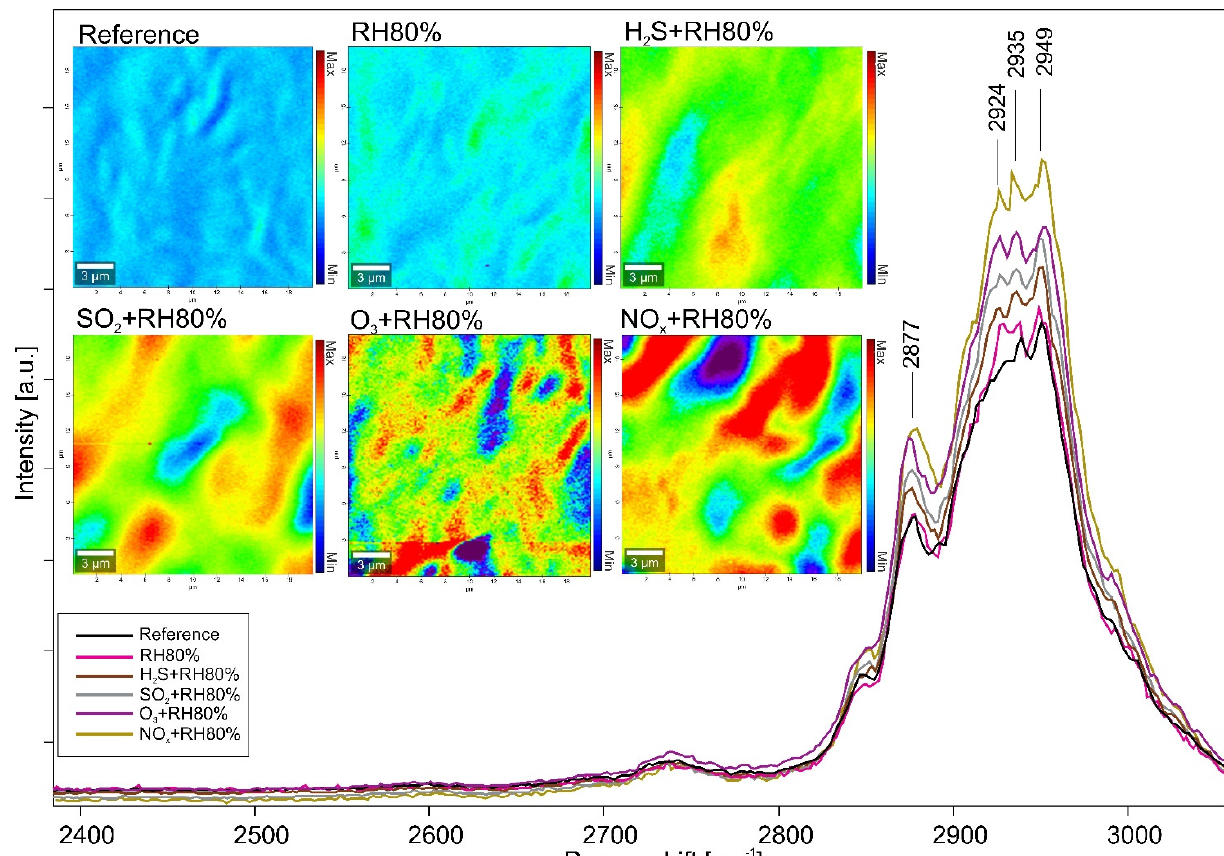
Figure 3. Raman chemical mapping of the PEO band at 2924 cm − 1 for all investigated acrylic samples.